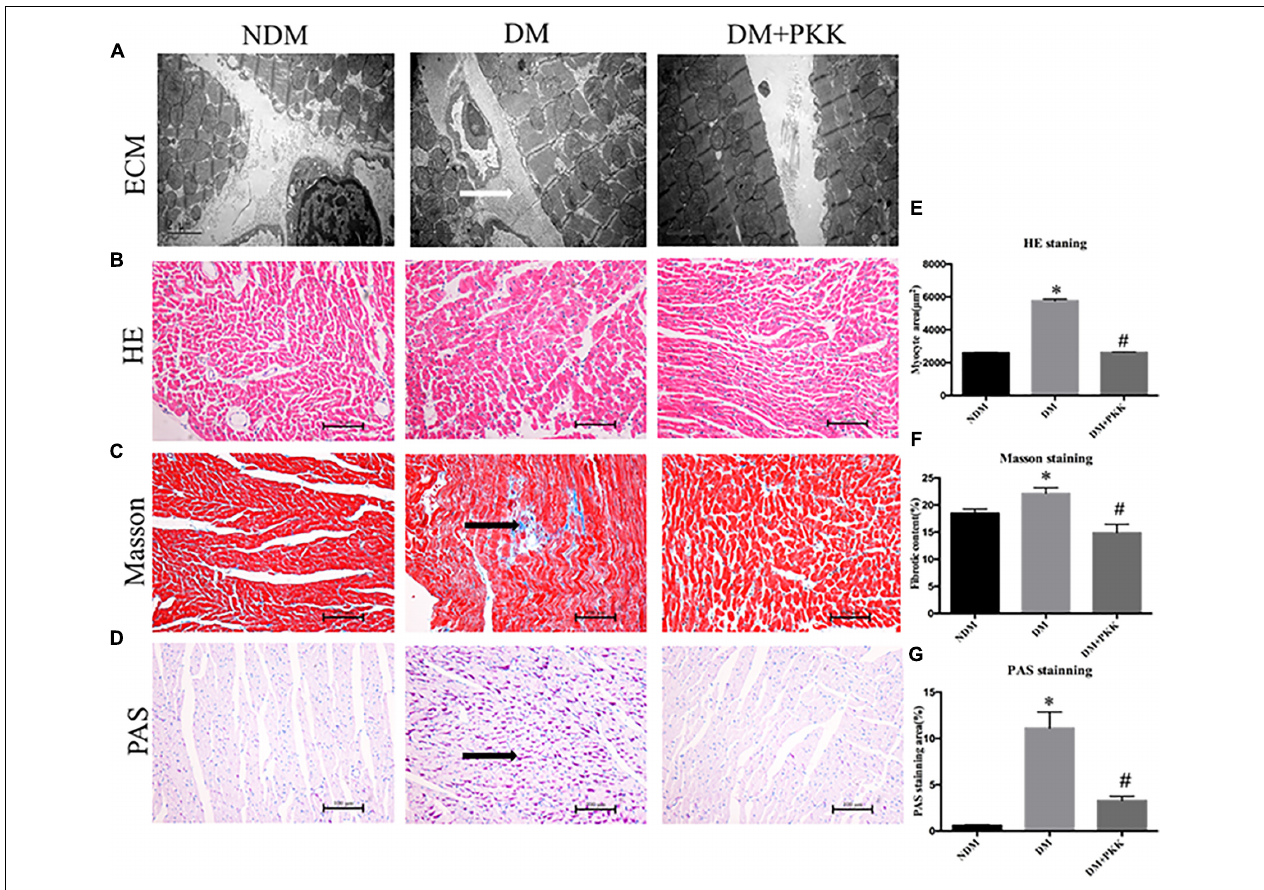
FIGURE 3 | Pancreatic kallikrein administration protected against myocardial hypertrophy and fibrosis in the diabetic rats. (A) Representative transmission electron microscopy micrographs of myocardium tissues. White arrow indicates the accumulated collagen in the myocardial matrix. Representative images of cardiac tissue stained with (B) hematoxylin and eosin, (C) Masson (black arrow indicates the accumulated collagen in the myocardial matrix), and (D) PAS (black arrow indicates the accumulated glycogen in cardiomyocytes) for the NDM, DM, and DM + PKK groups (original magnification × 40). (E) Quantitative results of the cross-sectional diameter of myocytes within transverse cardiac sections. (F,G) Quantitative results of the cardiac extracellular matrix and collagen accumulation with Masson and PAS for the NDM, DM, and DM + PKK groups are presented (original magnification x40). Values are mean ± SEM, n = 6 per group; ∗ P < 0.05 vs. NDM group; # P < 0.05 vs. DM + PKK